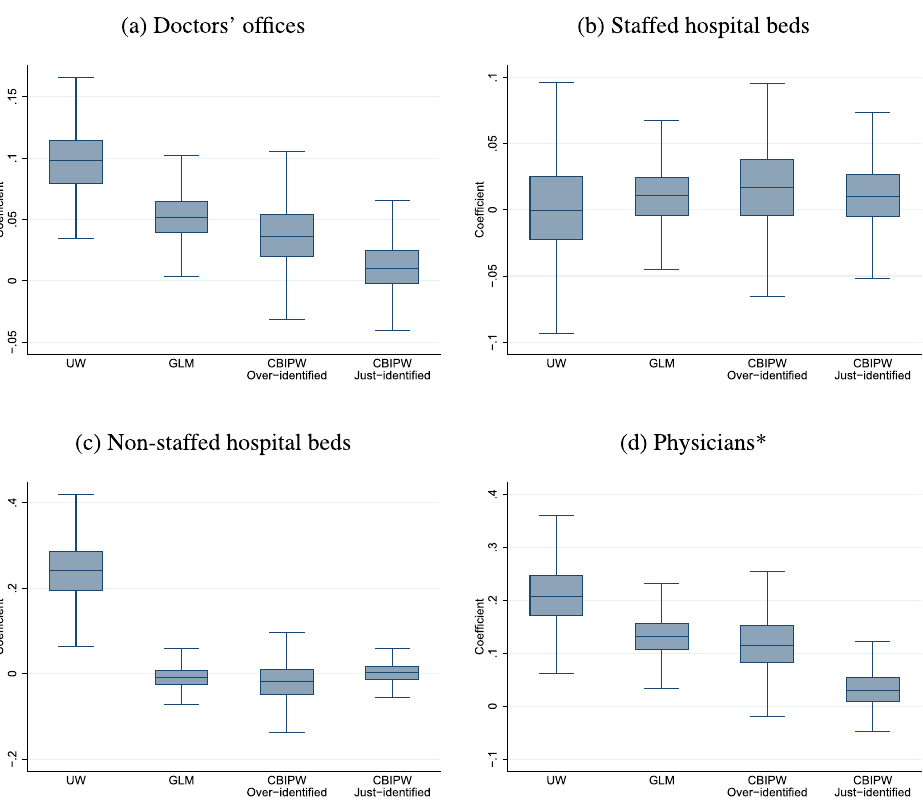
Figure 2: Covariate-Balance for Time-varying SP coverage on Sanitary Jurisdictions.